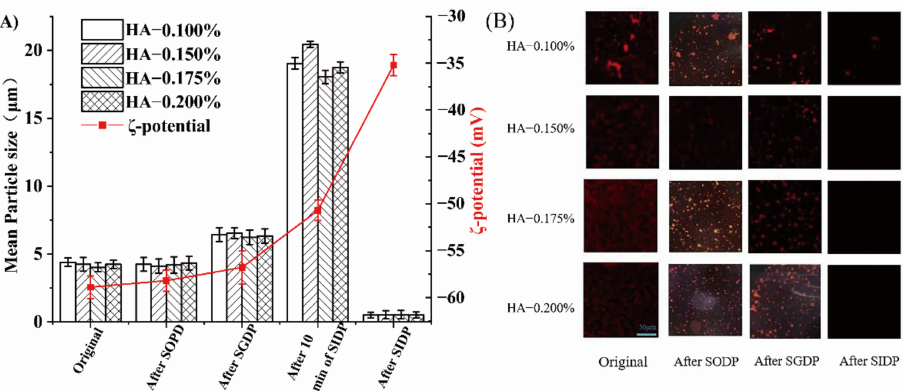
Figure 5. The changes of the MPS and ZP of emulsions during the simulated digestion period ( A ); laser confocal microscopy of HA- β -carotene emulsion in the SIDP ( B